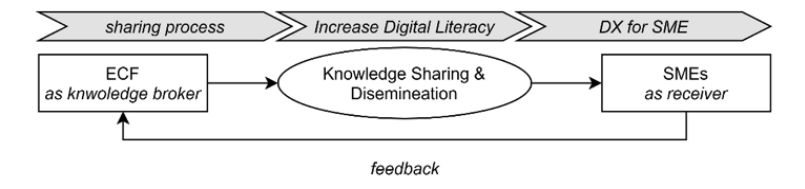
Figure 1: Conceptual Framework (KB for SMEs Digital